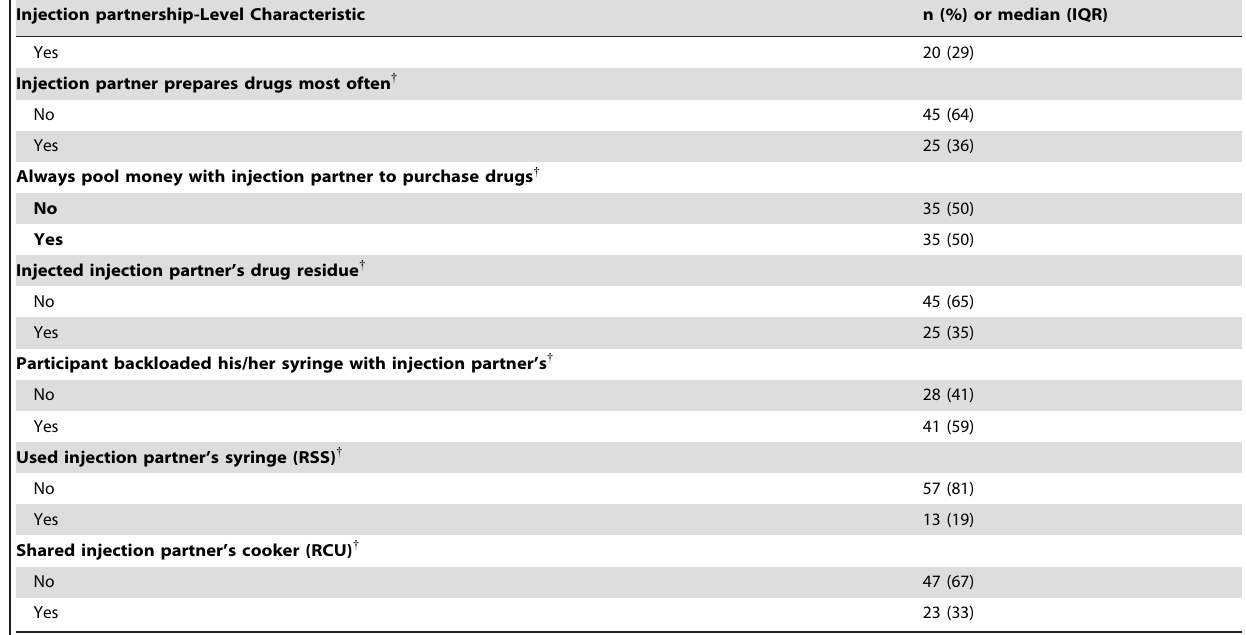
Injection partnership-Level